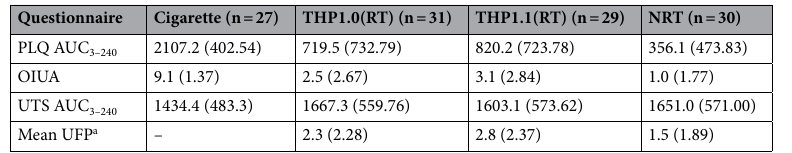
Table 4. Mean (SD) questionnaire scores for the four investigational products. Eleven subjects were excluded from the PP population due to major protocol deviations (7 × washout problem, 5 × questionnaire timing out of tolerance), therefore n = 27 for usual brand cigarette, n = 31 for glo THP1.0(RT), n = 29 for glo THP1.1(RT) and n = 30 for Nicorette 15 mg Inhalator. OIUA overall intent to use again, PLQ product liking questionnaire, UFP urge for product, UTS urge to smoke, THP tobacco heating product, NRT nicotine replacement therapy. a Mean of scores recorded at 15 and 120